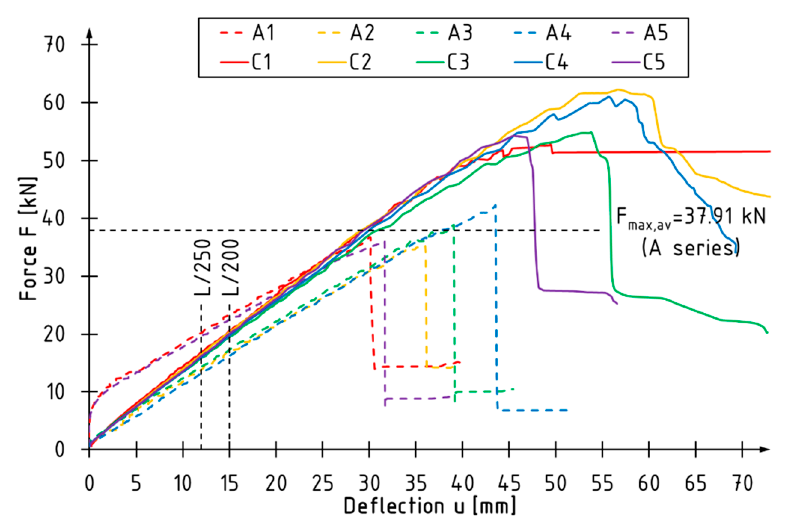
Figure 5. Load-deflection curves of D series beams. The unreinforced beams showed linear behavior from the beginning of the test to the point of failure. In the case of the B series beams, the curves describing the dependence of the loading force on the deflection almost coincided, and the failure occurred at a similar level of loading force (Figure 3). The curves of the beams reinforced with two layers of CFRP sheets (Series C and D) had similar characteristics in terms of the linear-elastic range (Figures 4 and 5). For reinforced beams, more ductile behavior was observed in the final phase of the test compared to the reference beams. As the level of reinforcement increased, the utilization of the compression zone and bending ductility increased. The results of the experimental tests, describing the maximum loading force F max , maximum bending moment M max and deflection at maximum force u F,max , are shown in Tables 5–8; the percentage increment values in relation to the reference beams are shown in brackets. Additionally, the beam failure modes are given in the table and are discussed in detail nelow.